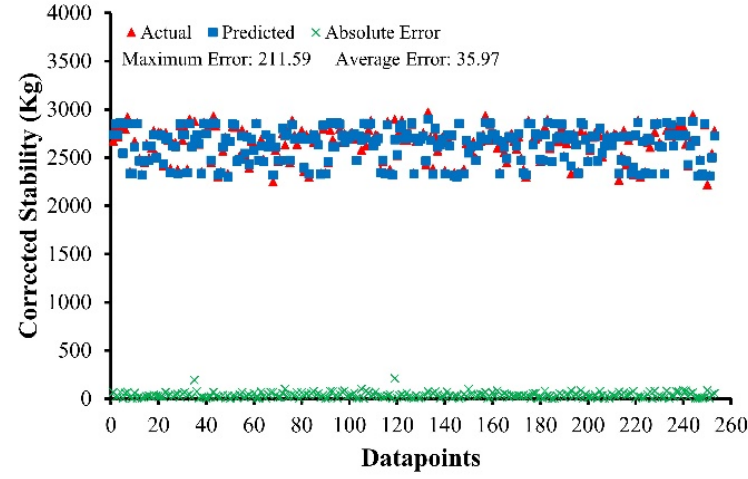
Figure 5. Absolute errors of ABC–MS.